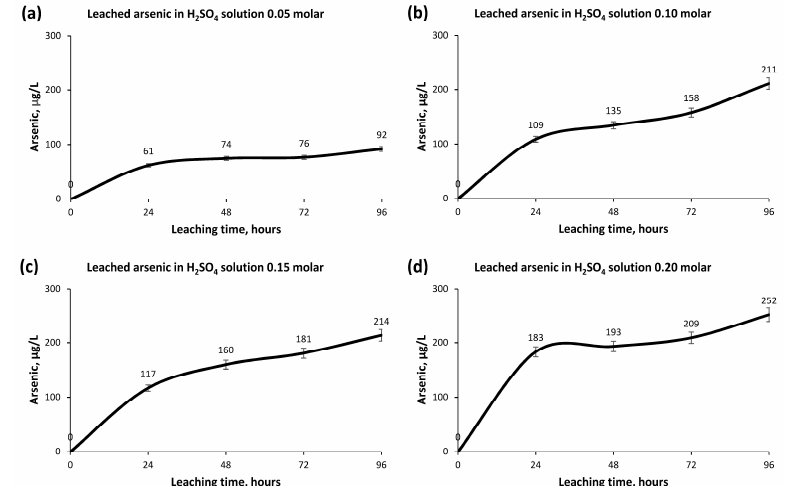
Figure 12. Analysis of Arsenic concentration in the leaching process at atmospheric pressure, ambient temperature and in different Sulphuric Acid solutions: ( a ) 0.05 molar H 2 SO 4 solution, ( b ) 0.10 molar H 2 SO 4 solution, ( c ) 0.15 molar H 2 SO 4 solution and ( d ) 0.20 molar H 2 SO 4 solution. Arsenic is not an element of interest in recovery by this hydrometallurgical process for different reasons; among them, its low percentage in the sample and the environmental problem that it represents. However, it is an element that seriously damages the pyrometallurgical process and, to a lesser extent, the hydrometallurgical process. Therefore, the low existence of this element in the sample and the low recovery that has been obtained in the leaching, approximately 2%, confirms the quality of the leachate obtained for the extraction of Copper. Furthermore, it confirms the adequacy of the molarity of the Sulphuric Acid in the solutions and the leaching times, since a higher molarity for the extraction of a percentage of Copper would cause an unnecessary leaching of the elements commented as well as of the Arsenic, damaging the process and not obtaining substantial differences in the extraction of Copper due to the increase of the molarity of the Sulphuric Acid solution. Figure 13 shows the maximum leaching values obtained for the elements detailed above with the 0.20 molar solution of Sulphuric Acid, at ambient temperature and atmospheric pressure.